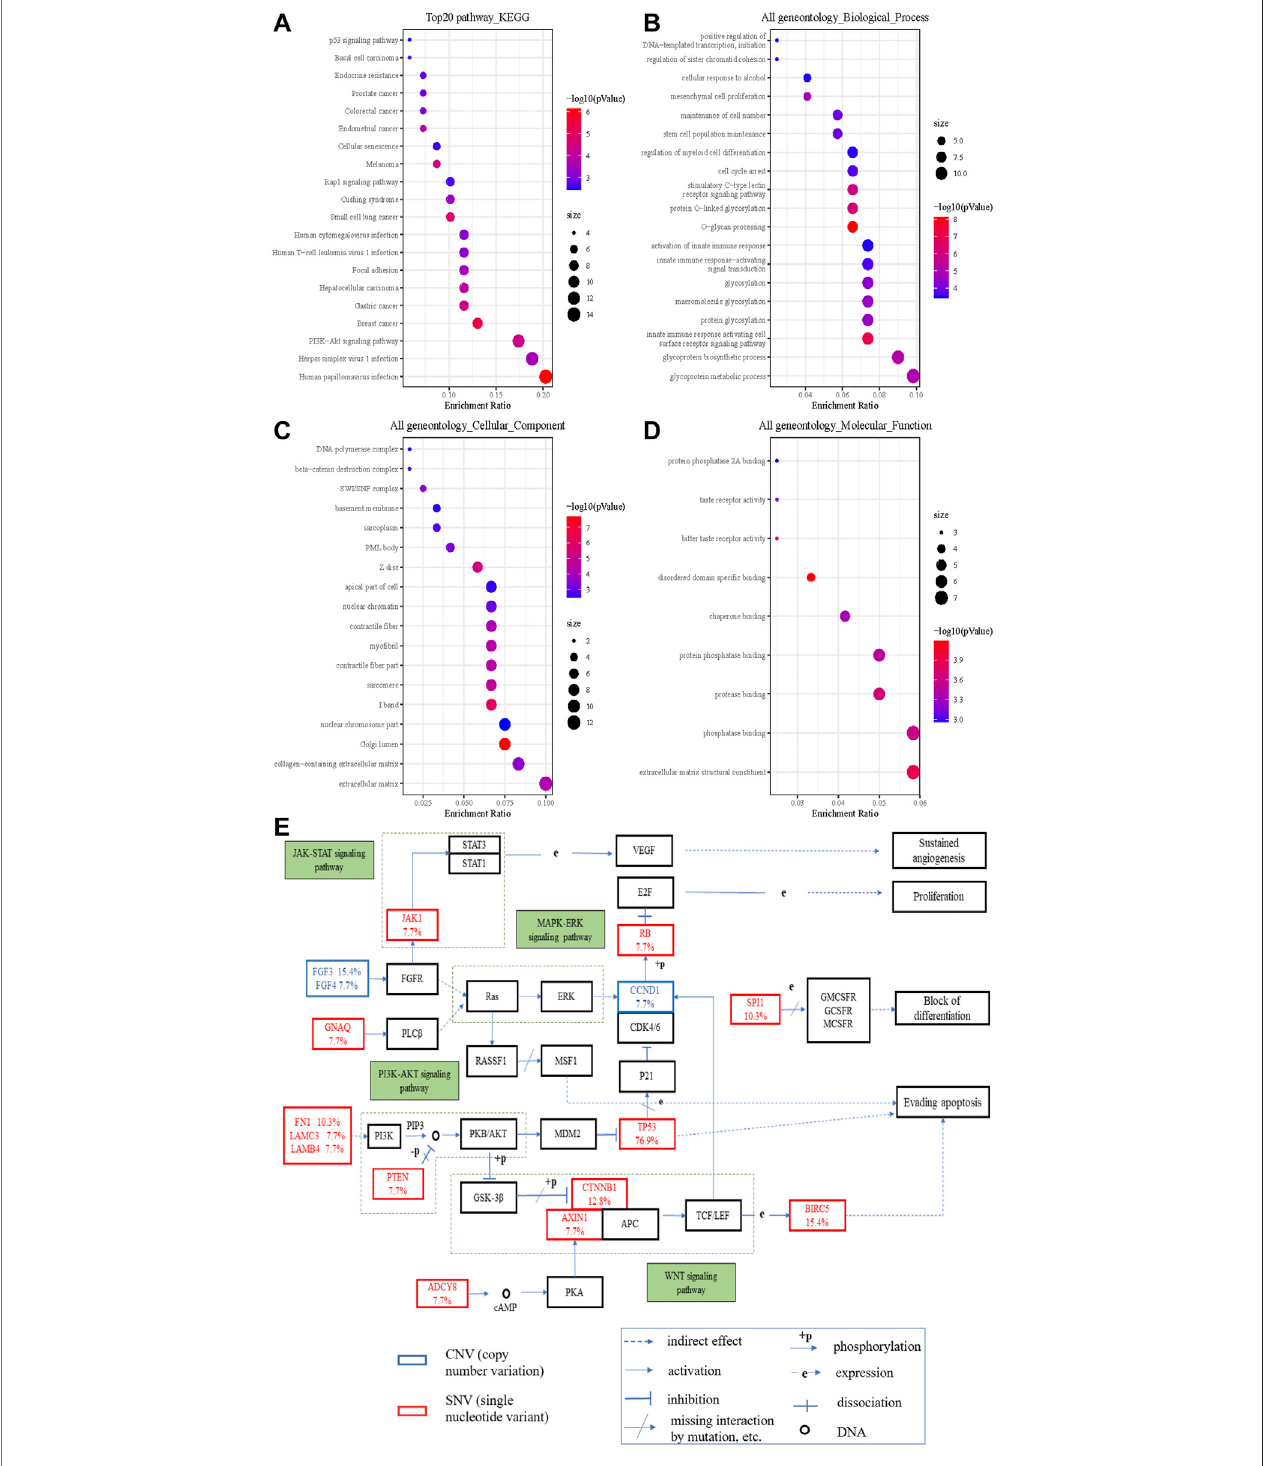
FIGURE 3 | The signi fi cantly enriched GO annotations and the KEGG pathways of somatic cell variants in HCC cases. (A) KEGG pathway analysis; (B) biological processes; (C) cellular components; (D) molecular functions; (E) KEGG pathway annotations of the cancer related pathway, with red lettering denoting SNVs and blue lettering denoting CNVs. The number represents the frequency of